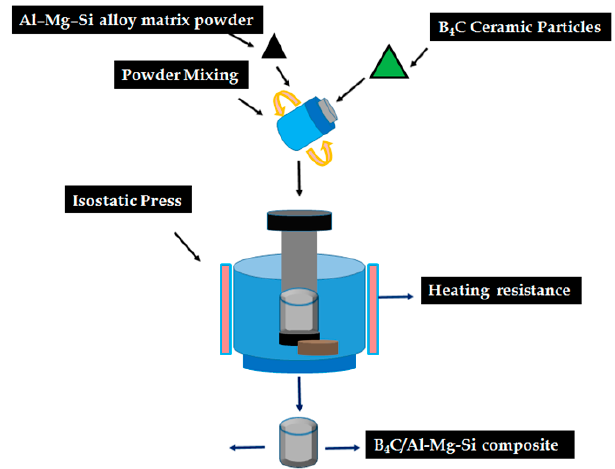
Figure 1. The schematic diagram for composite fabrication by P/M route in this study.